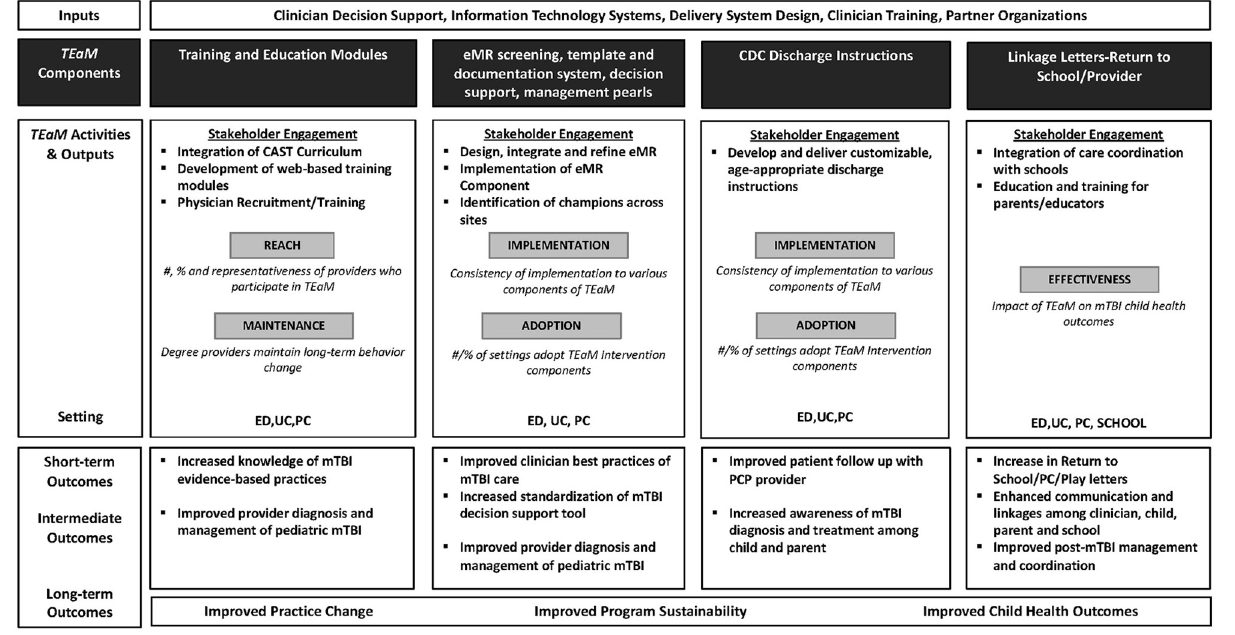
Secondary Outcomes—(PCSI Emotion Scale,